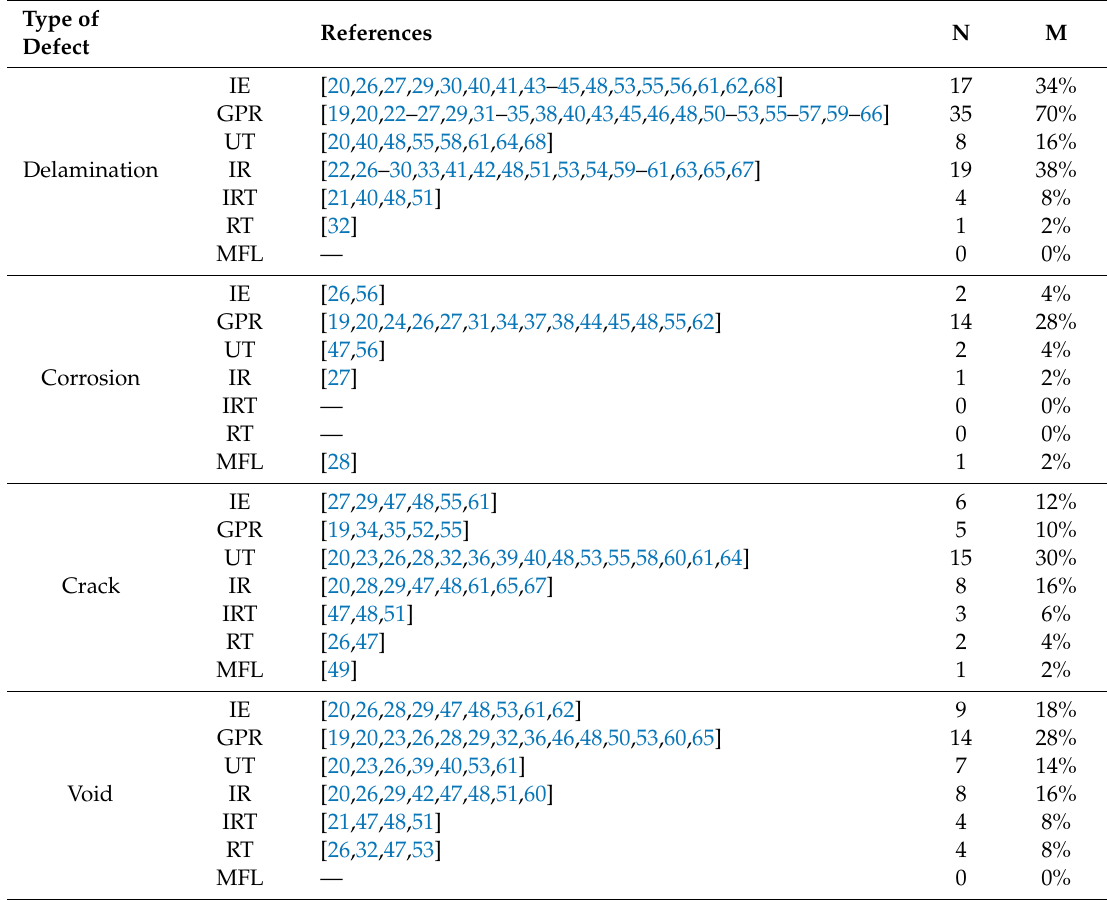
Table 3. Statistical survey of applicability of NDT methods to defects in ABC closure joints [19–68]. Type of